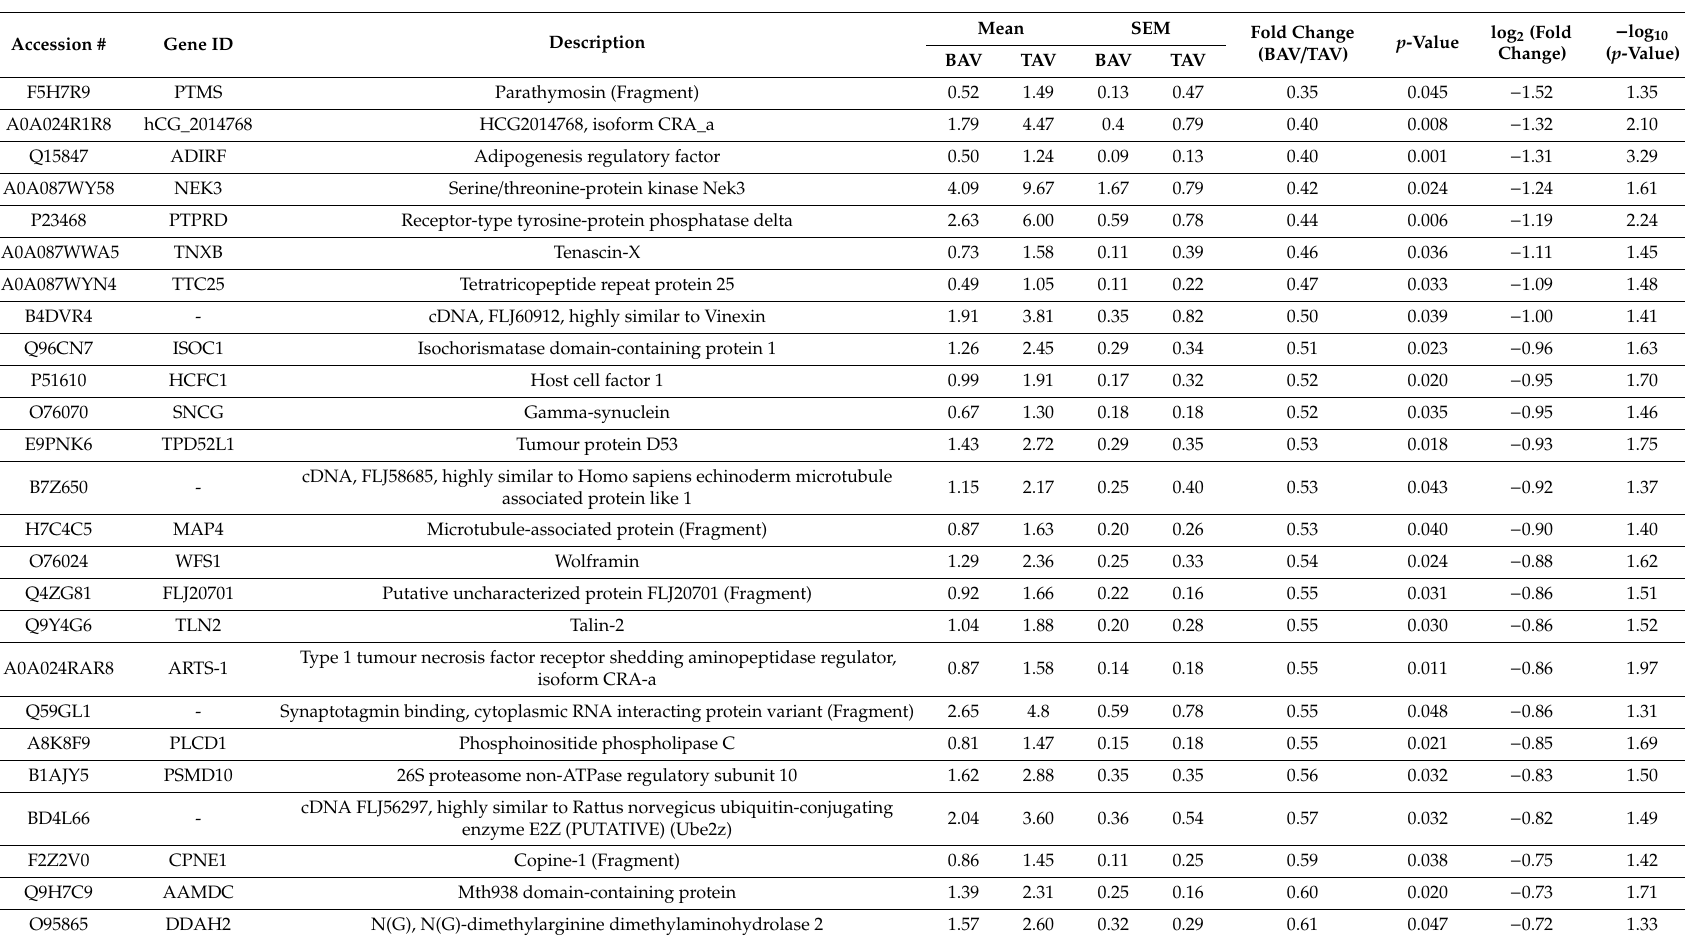
Table 1. Proteins di ff erentially (fold decrease / increase > ± 1.3)) and significantly ( p < 0.05) expressed in coarcted aorta from neonatal BAV patients compared to neonatal TAV